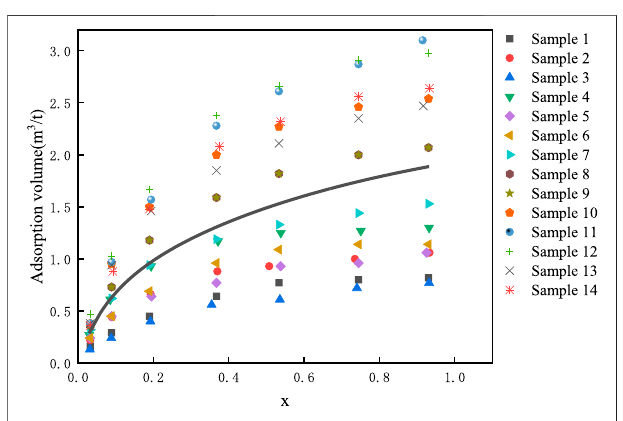
FIGURE 1 | Actual isotherm adsorption curve of shale gas Block XX.